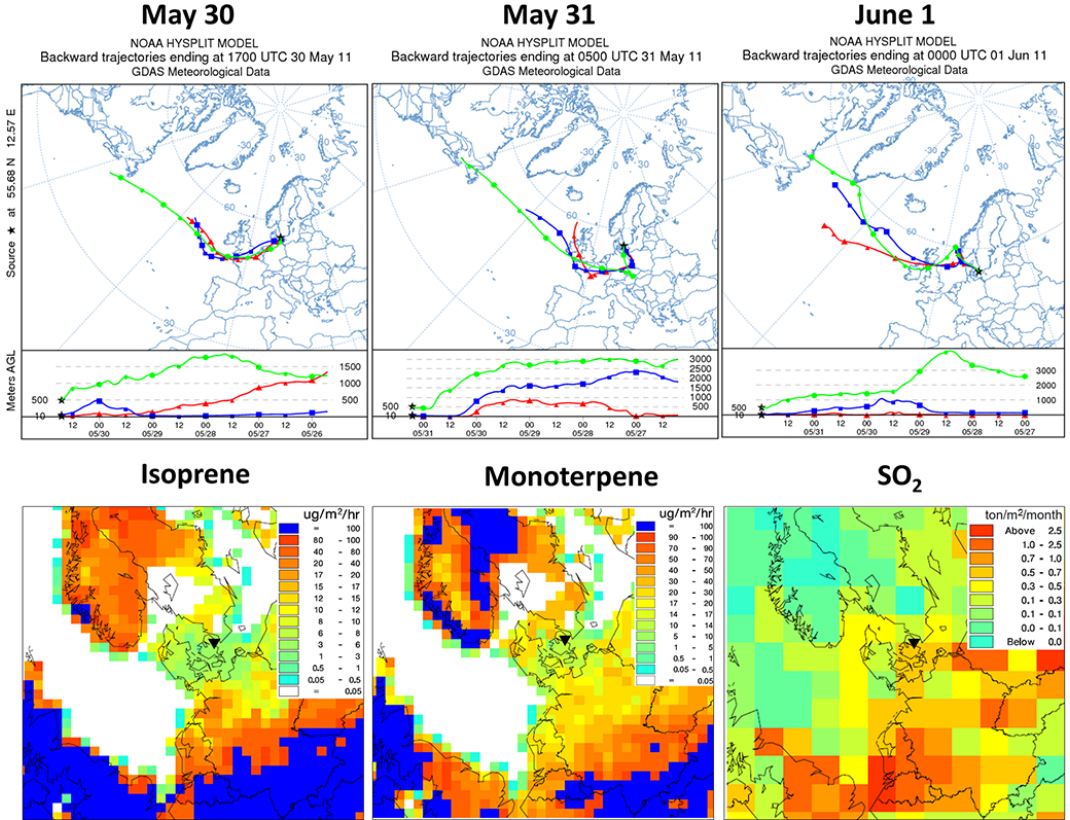
Figure 4. A sudden change in air mass back trajectories on 31 May to southeasterly direction was coupled with elevated concentrations of organosulfates, nitrooxy organosulfates, and organic acids at both HCAB and Risø. Modeled daily isoprene and monoterpene emissions did not vary significantly over the 3 days. The SO 2 emission map (May–June average) showed a higher abundance of emission hotspots in the southeasterly direction (observed on 31 May) compared to the westerly direction (observed on 30 May and 1 June). HCAB is marked at the bottom tip of the black